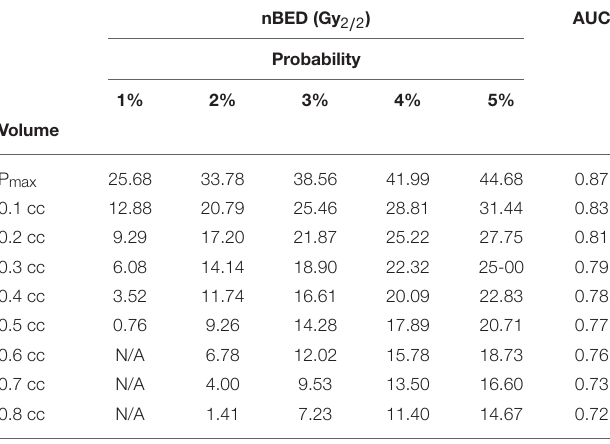
TABLE 6 | Calculated nBED (Gy 2 / 2 ) for different probabilities of RM based on logistic regression models. nBED (Gy 2 / 2 )